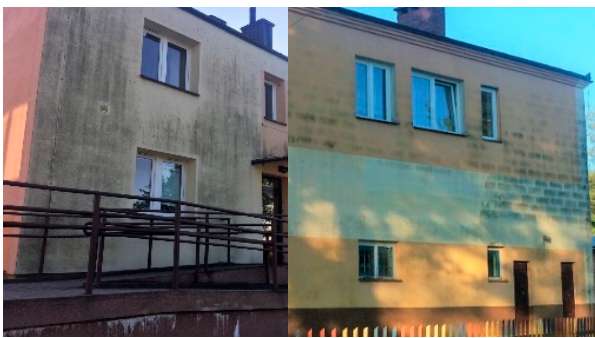
Figure 2. Algae covering the façade surfaces of one of the buildings found during field studies. The microbiological contamination occurs in the form of bioaerosols, i.e., biological particles suspended in the air. There are various microorganisms and organic matter molecules coming from many sources. The source of bioaerosols involves the people and animals living in the apartment. The contaminants produced by fungi and molds in high concentrations originate mainly from the organisms growing in the dwelling [42,80,81]. According to Reference [61], the concentration of fungal spores in the contaminated buildings, expressed in colony-forming units (CFU), exceeds 1000 CFU/m 3 , while the permitted amount is 50 CFU/m 3 for mold fungi and 150 CFU/m 3 for mixed genera—with the exception of pathogens.